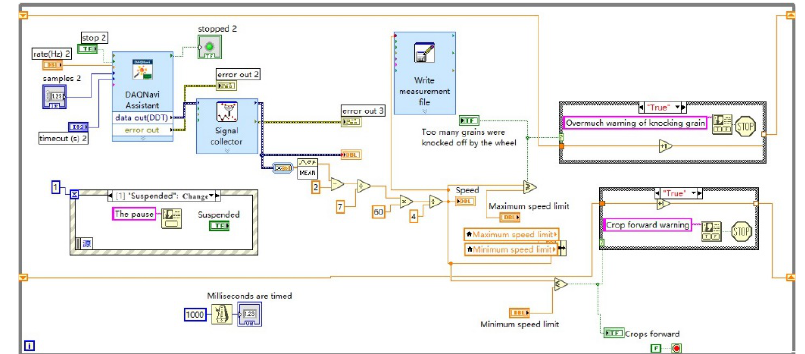
Figure 9. Speed acquisition program block diagram .